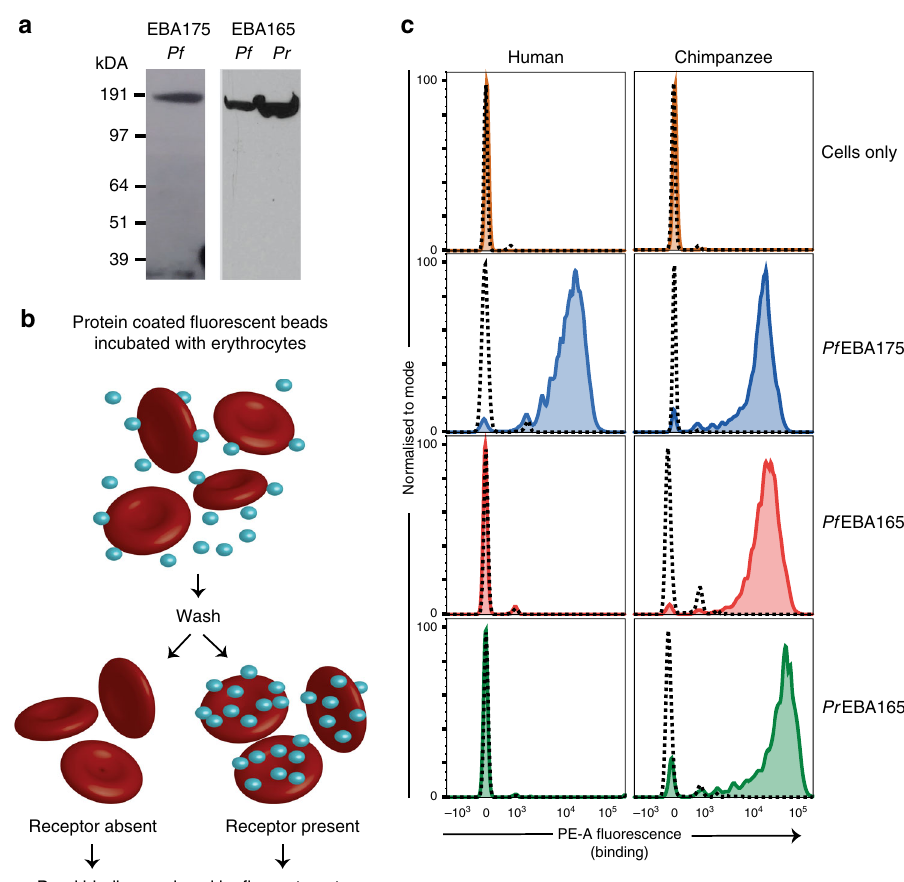
Fig. 2 PfEBA165 and PrEBA165 bind chimpanzee, but not human, erythrocytes. a Recombinant PfEBA165, PrEBA165 and PfEBA175 ectodomains were expressed as secreted mono-biotinylated proteins in HEK239E cells. Immunoblots of HEK293E cell supernatant were probed with HRP-linked streptavidin to con fi rm expression of a single band of the expected sizes (PfEBA175: 188 kDa; PfEBA165: 177 kDa; PrEBA165: 177 kDa). The blot images displayed have been cropped and Source Data are provided as a Source Data File. b Cartoon outline of erythrocyte binding assays. Enzymatically mono-biotinylated proteins were captured on streptavidin-coated fl uorescent beads, and incubated with either human or chimpanzee erythrocytes. After repeated washing, binding of fl uorescent beads to the erythrocytes was detected using fl ow cytometry. c Erythrocyte binding assay using human and chimpanzee red blood cells incubated with PfEBA165, PrEBA165 and PfEBA175. Solid coloured lines indicate traces after binding to untreated erythrocytes, showing that PfEBA175 binds to both human and chimpanzee erythrocytes, whereas PfEBA165 and PrEBA165 bind only to chimpanzee erythrocytes. In all cases, binding is abrogated by neuraminidase treatment (dashed lines), which removes extracellular sialic acids. Assays were conducted in triplicate with the same batches of proteins and erythrocytes. Individual assays included three technical replicates for each condition tested; a single representative technical replicate is